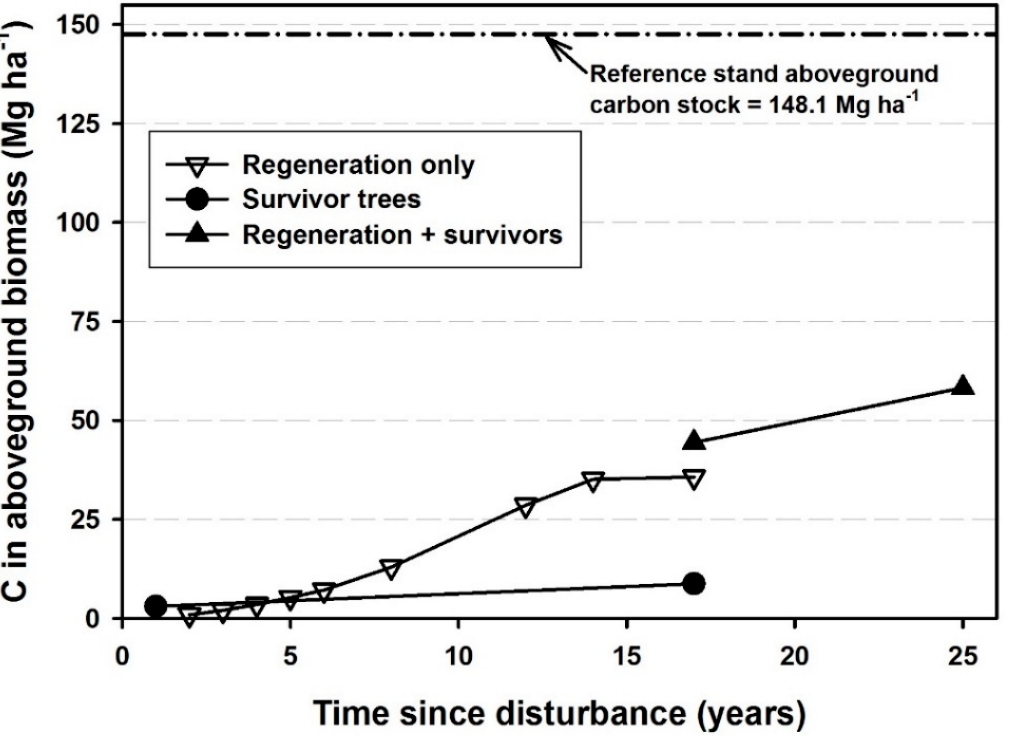
Figure 2. Carbon accumulation across 25 years following catastrophic windthrow at the Tionesta Scenic Area, Pennsylvania.